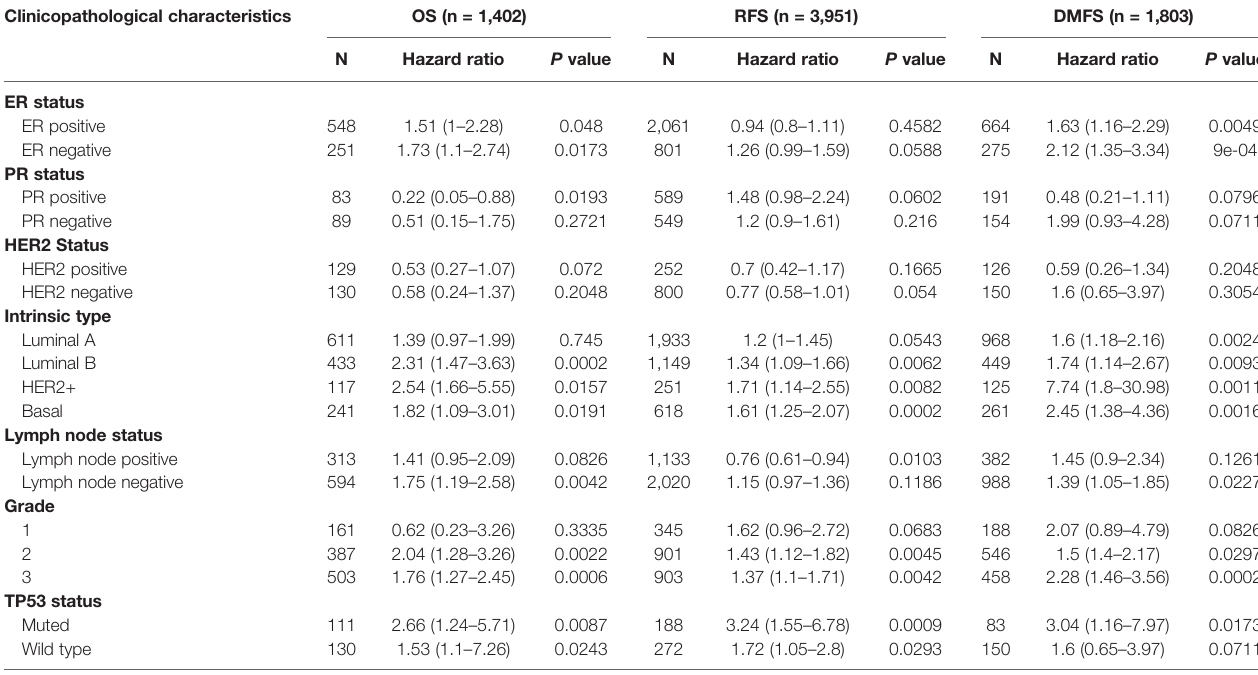
TABLE 1 | The correlation between SPINT1 expression and prognosis in breast cancer patients with different clinicopathological parameters. Clinicopathological characteristics